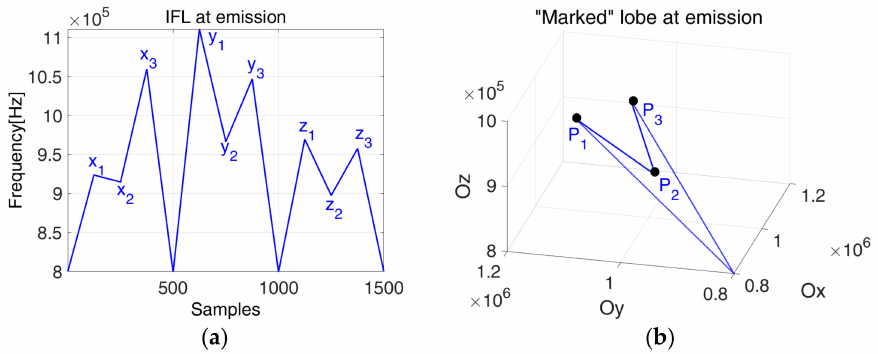
Figure 21. ( a ) The IF law used at emission; ( b ) the corresponding “marked” phase space